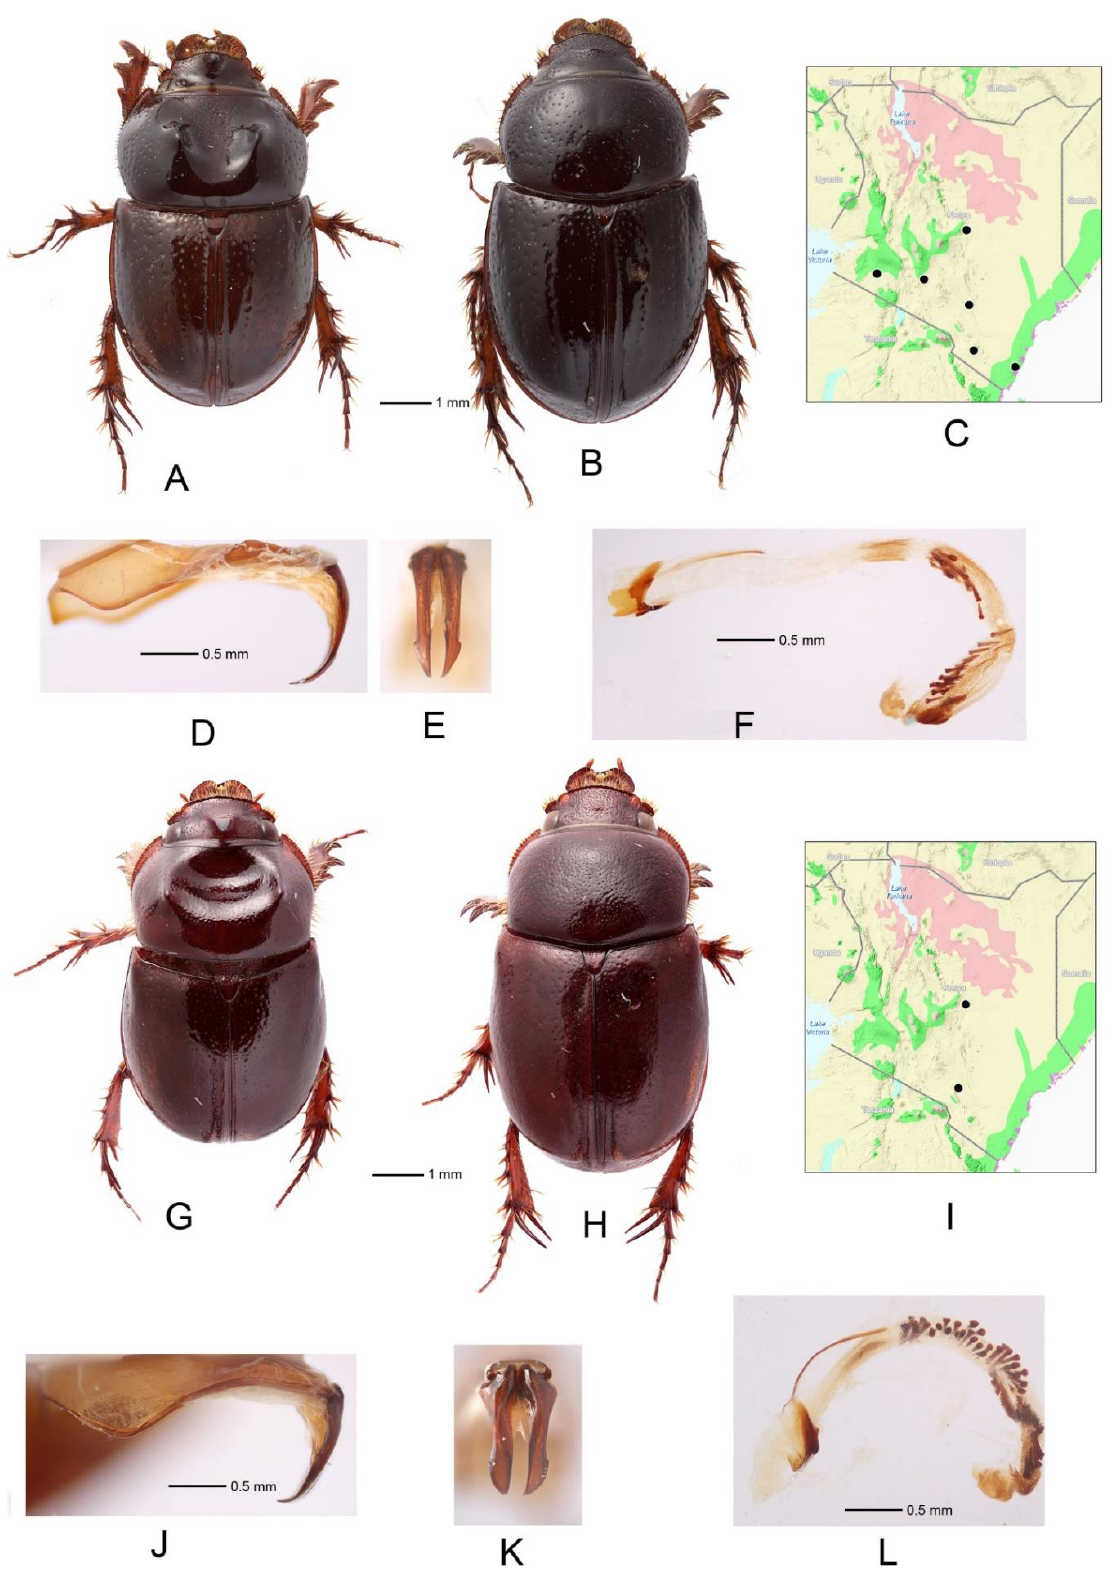
Figure 3. Orphnus mombasaensis Benderitter, 1914 ( A – F ) and O. tristis Pic, 1928 ( G – L ). ( A , G ) male, habitus; ( B , H ) female, habitus; ( D , J ) aedeagus in lateral view; ( E , K ) parameres in dorsal view; ( F , L ) endophallus; ( C , I ) distributional record map.